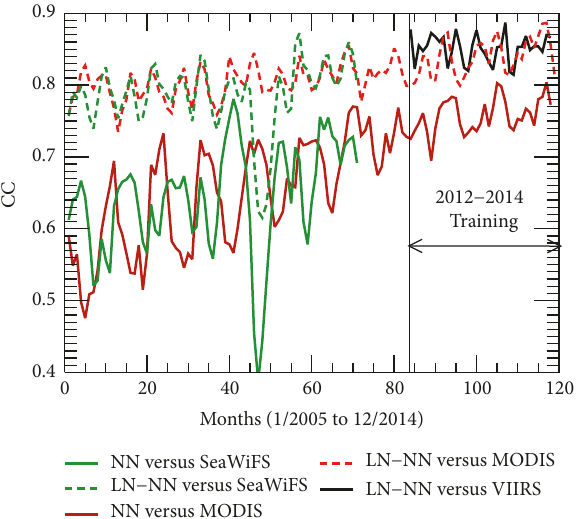
Figure 10: Correlationbetween monthly mean chl-aconcentrations simulatedby NN(solid) and LN-NN(dashed) ensembles and VIIRS (black), MODIS (red), and SeaWiFS (green) data.